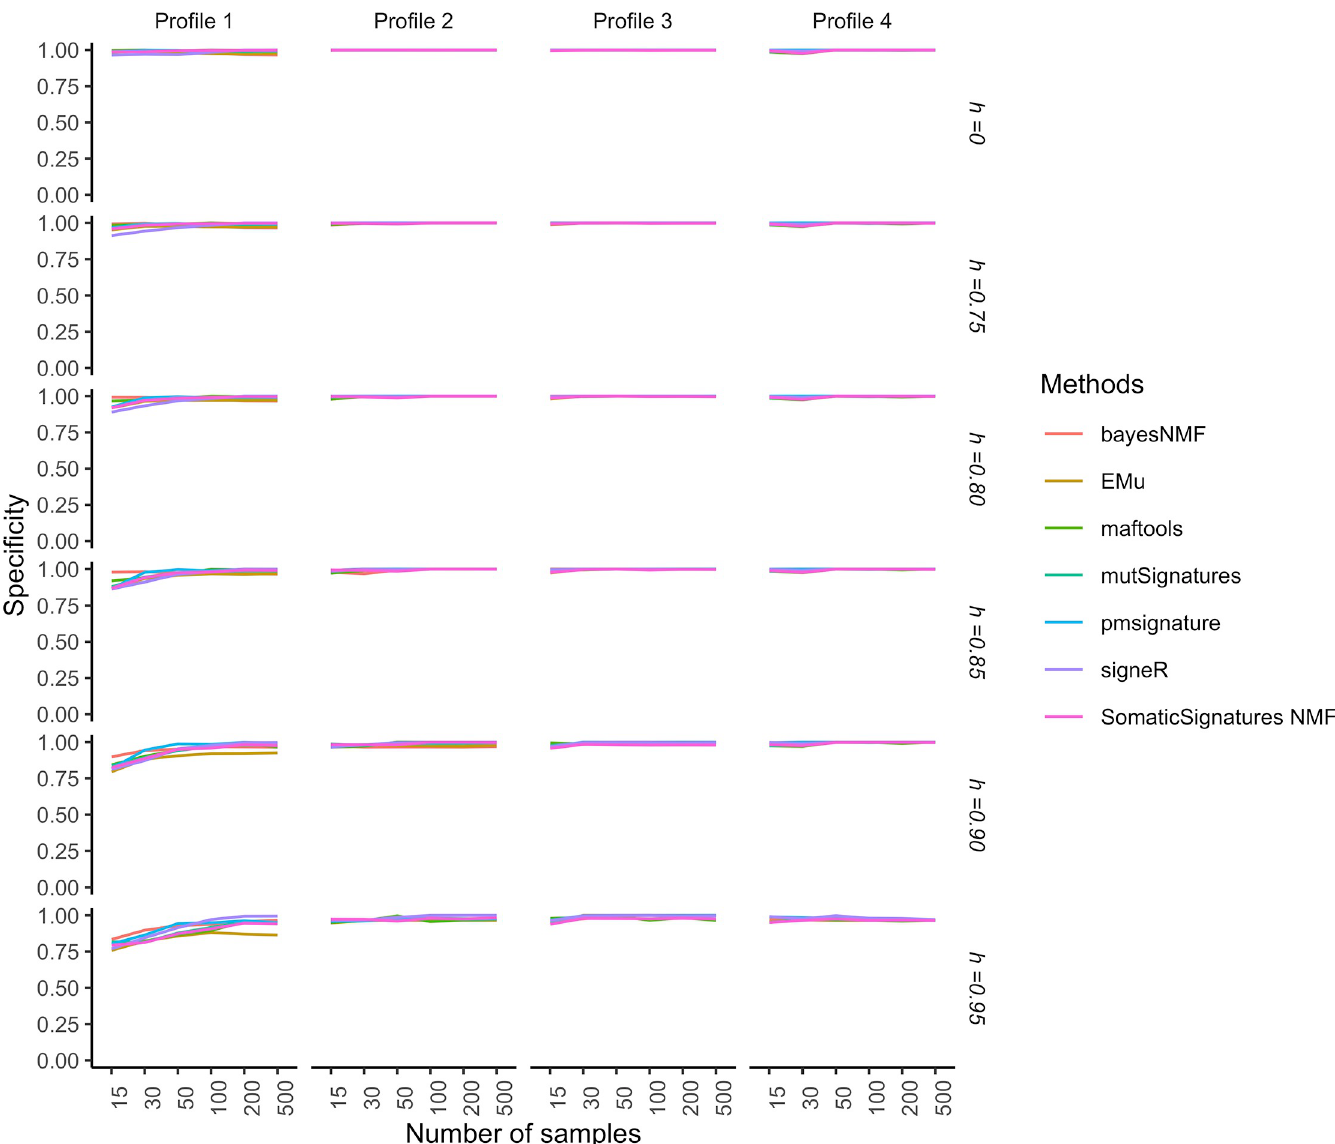
Fig 4. Simulation study: Specificity of extraction methods and mapping on COSMIC signatures as the number of analysed catalogues and the cosine cut-off h vary. Specificity is estimated from 50 replicates each made of G genomes. The average number of mutations in each catalogue is r = 10,000. The model used to simulate realistic replicates according to the four Profiles and the estimation methods are described in the section Data and experimental settings.